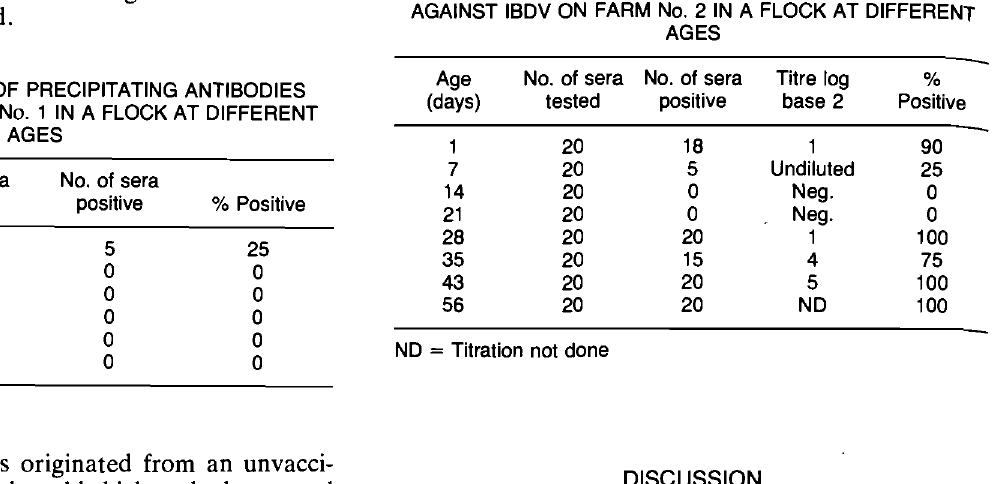
Table 3: DISTRIBUTION OF PRECIPITATING ANTIBODIES AGAINST IBDV ON FARM No.2 IN A FLOCK AT DIFFERENT AGES Age No. of sera No. of sera Titre